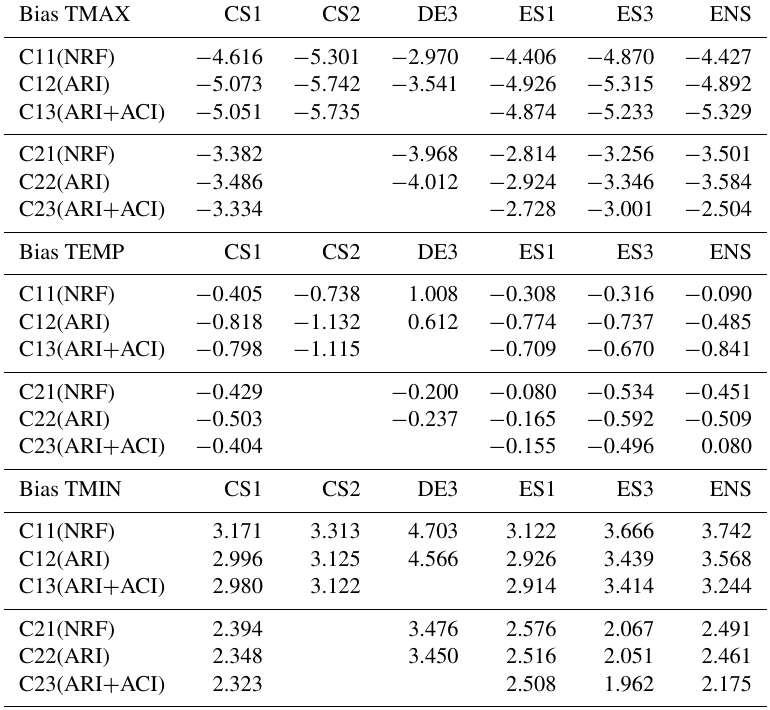
Table 3. Bias (in K) in those areas affected by high aerosol optical depths (1h AOD > 1.0 for the fires, C1X case, and AOD > 0.5 for the dust, C2X case) with respect to the E-OBS